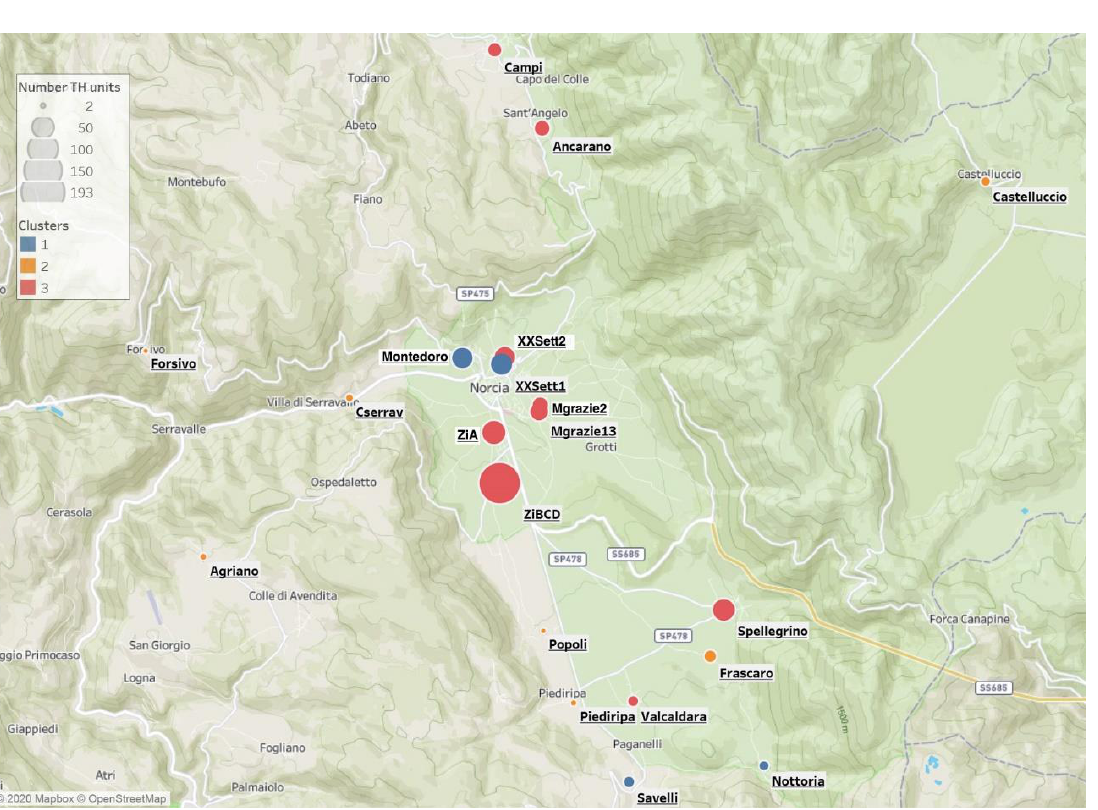
Figure 8 Final clustering result of Norcia TH sites transferred on a ®Tableau dashboard